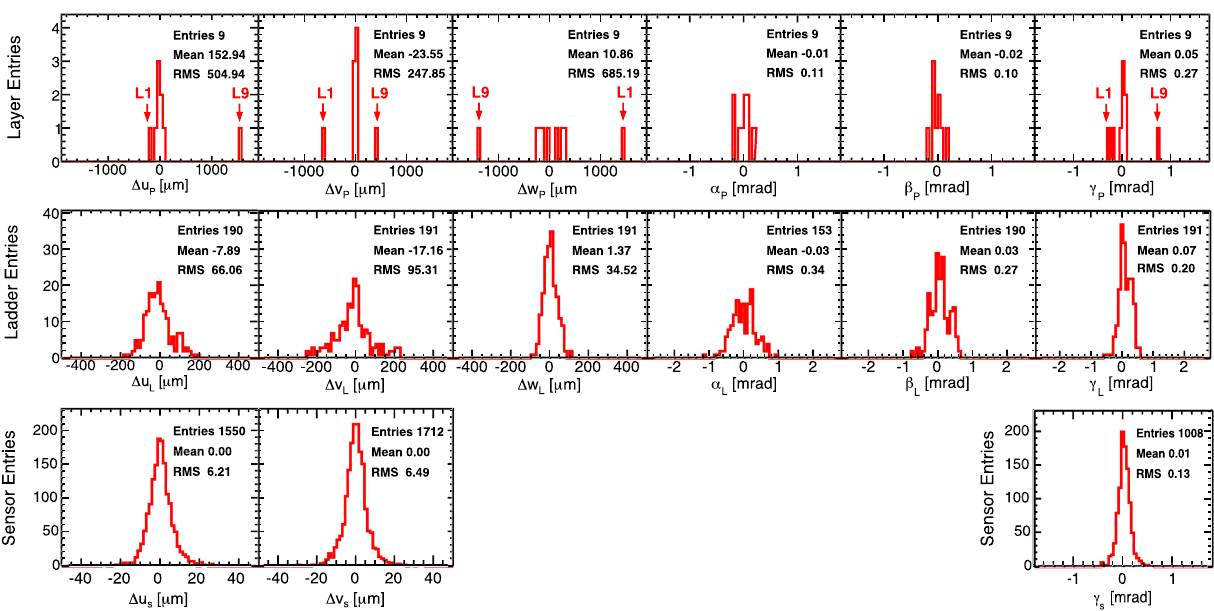
Fig. 8 The distributions of the alignment parameters of layers (top row), ladders (middle row), and sensors (bottom row) obtained from the test-beam alignment. The fixed alignment parameters are not